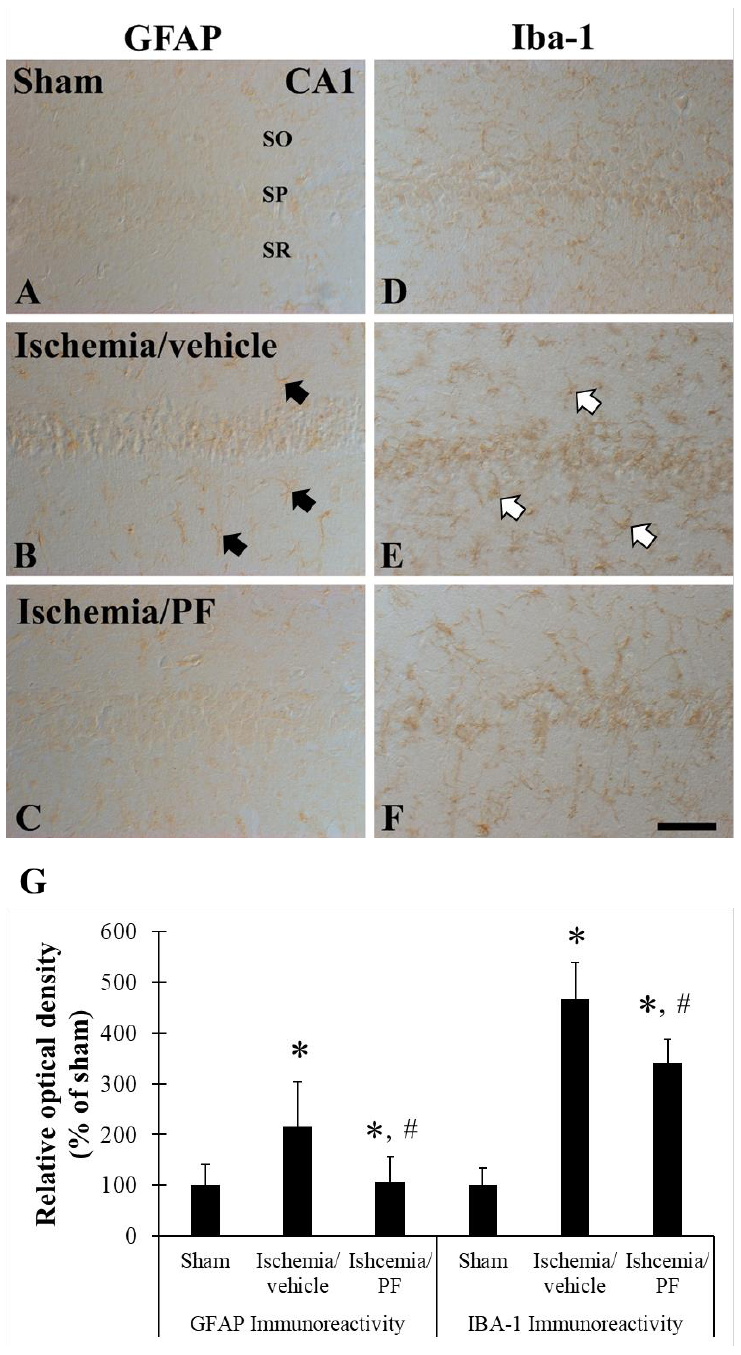
Figure 8. The 75% EEPF suppresses the ischemia-induced glial cell activation. Glial fibrillary acidic protein (GFAP) ( A – C ) Ionized calcium binding adaptor molecule-1 (Iba-1) ( D – F ) immunohistochemistry in the hippocampal CA1 region ( D – I ) of the sham ( A , D ), ischemia/vehicle ( B , E ), ischemia/PF ( C , F ) groups at 5 days after ischemic surgery. In the ischemia/vehicle groups, GFAP (black arrows) and Iba-1 (white arrows) immunoreactivities are increased in the CA1 region. In the ischemia/PF group, GFAP and Iba-1 immunoreactivities are decreased compared with that in the ischemia/vehicle group. Scale bar = 100 µ m ( G ). Relative optical density (ROD) of GFAP and Iba-1 in the CA1 region (n = 7 for each group, * p < 0.05 versus sham group, # p < 0.05 versus ischemia/vehicle group). The bars indicate the means ± SEM.